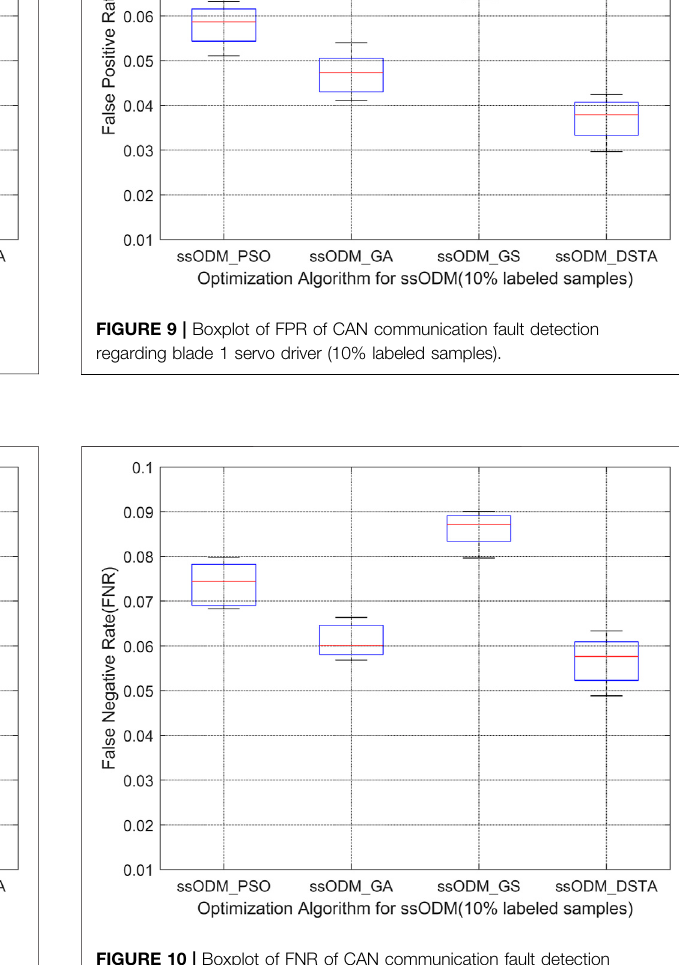
FIGURE 8 | Boxplot of FNR of CAN communication fault detection regarding blade 1 servo driver (5% labeled samples).